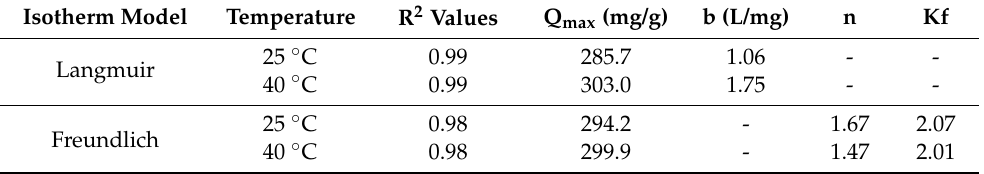
Table 3. Isotherm parameters for the adsorption of Pb 2+ onto BC/GO materials. Isotherm Model